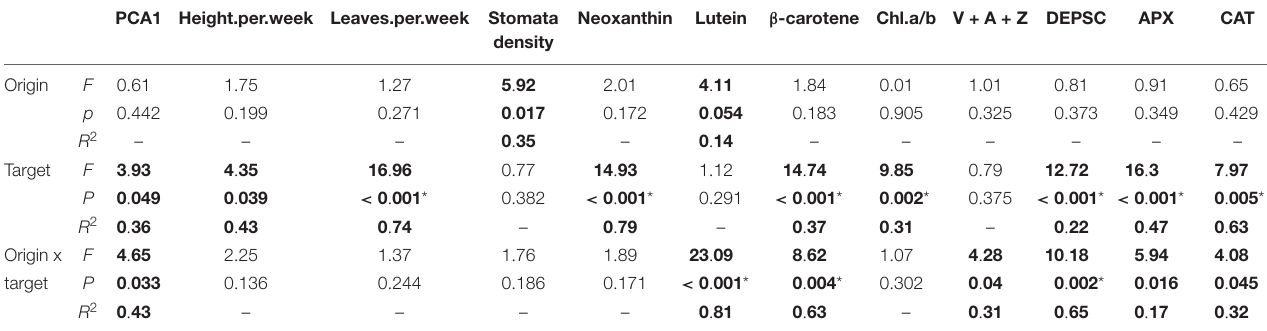
Results for stomata length, SOD isozyme number, SOD activity and Fv/Fm are not shown in the table as none of the predictors was significant (p > 0.05). Year of sampling was used as a covariate and population as a random factor in all the models. PCA1 represents first ordination axis from a multivariate analysis of the traits. R 2 indicates